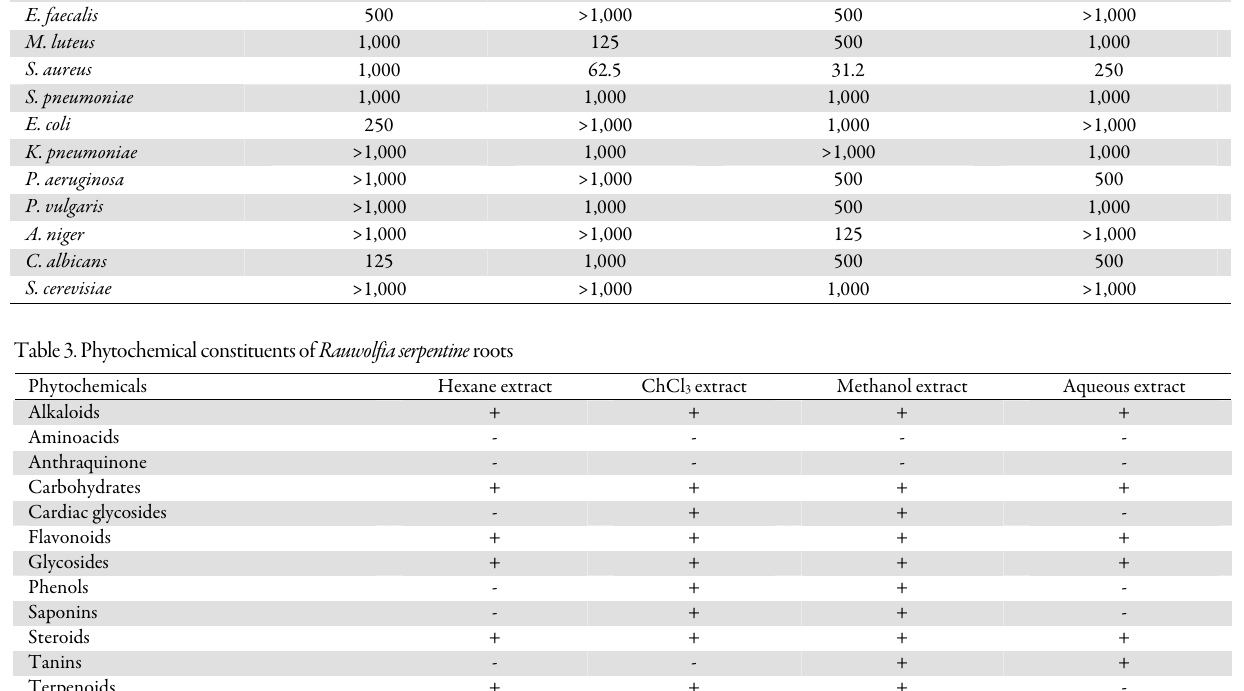
Cardiac glycosides - Glycosides Steroids